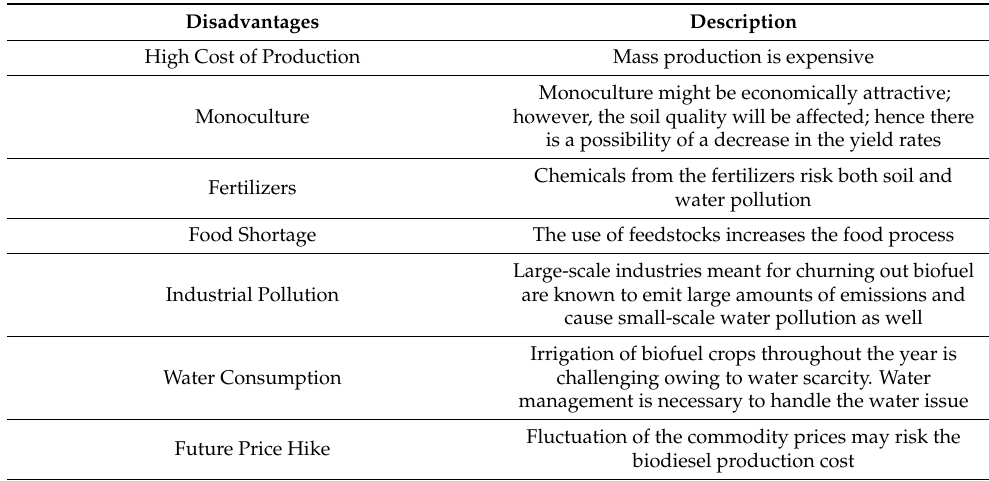
Table 3. Disadvantages of biofuels over fossil